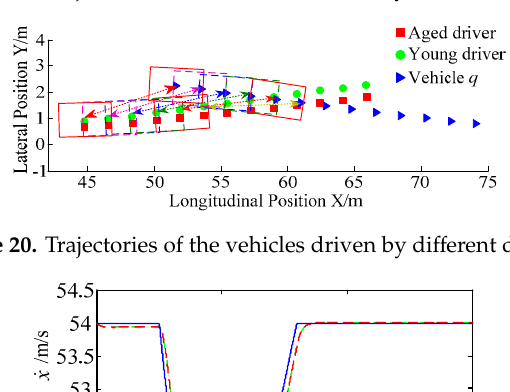
Sensors 2020 , 18 , x FOR PEER REVIEW Figure 19. Trajectories of the vehicles driven by different drivers. Figure 19. Trajectories of the vehicles driven by di ff erent drivers.